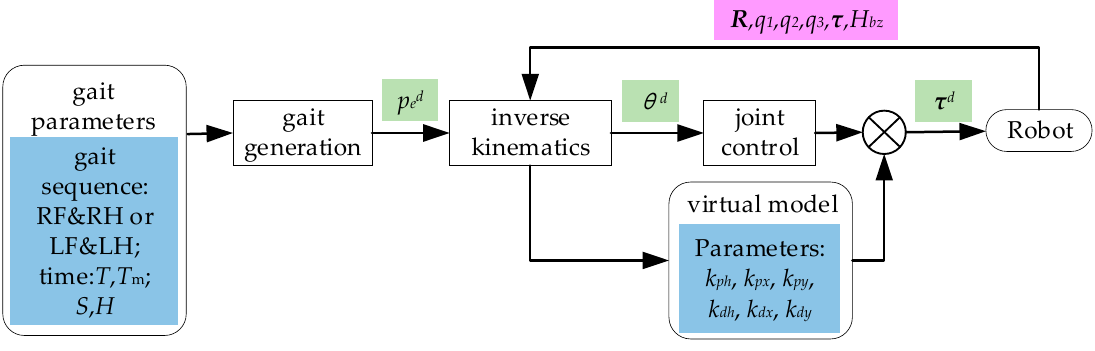
Figure 5. Block diagram of controller frame.